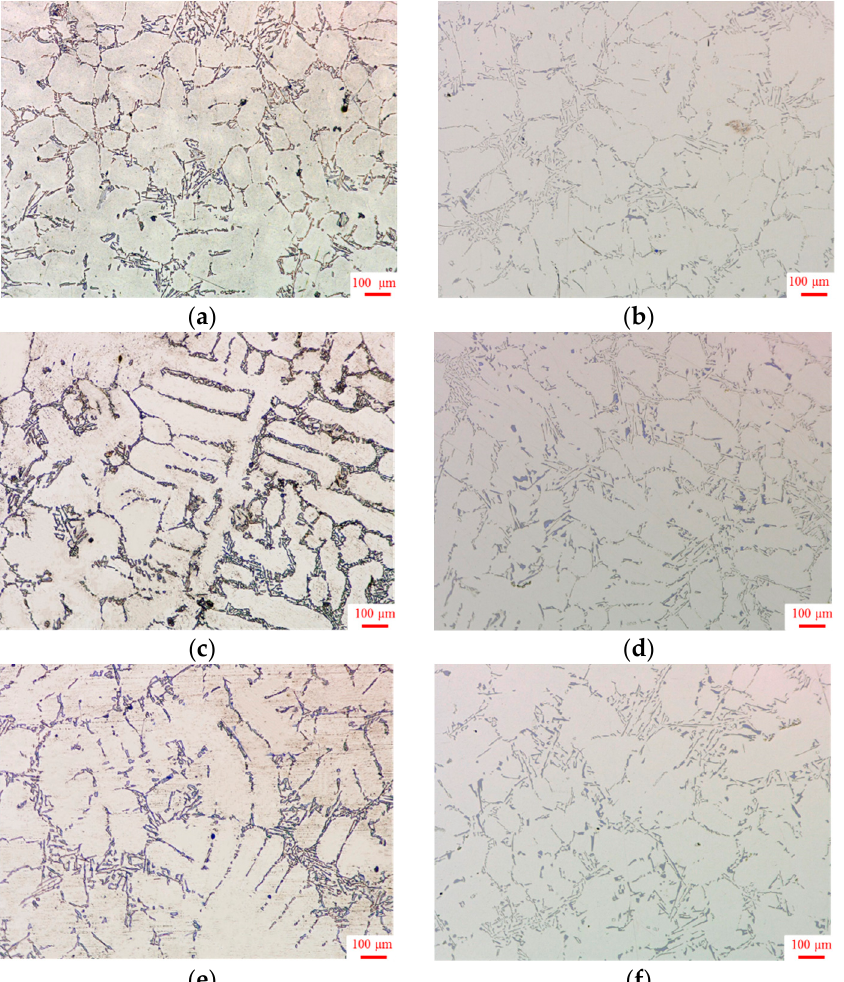
Figure 13. Optical micrographs of the castings under different conditions. ( a ) As-cast-P1DN, ( b ) T6- P1DN, ( c ) As-cast-P1HN, ( d ) T6-P1HN, ( e ) As-cast-P2HF, ( f ) Table 6. EDS results of the three castings.